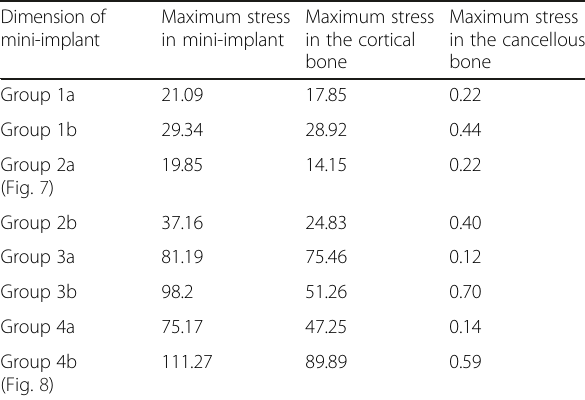
Table 5 Maximum von Mises stress (MPa) for direction of force simulating molar intrusion Dimension of